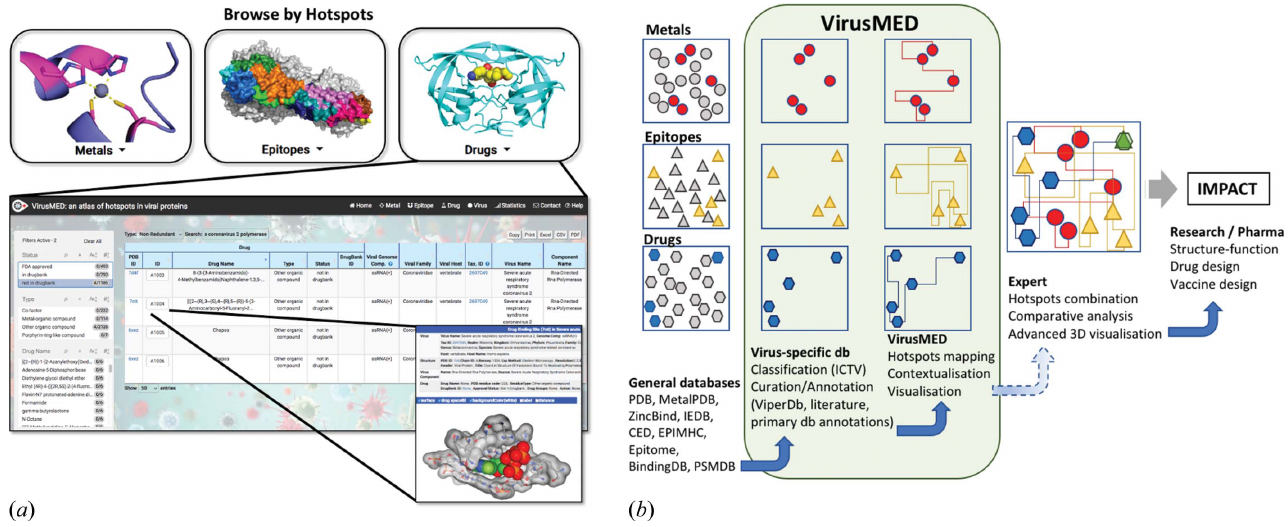
Figure 1 ( a ) virusMED is an atlas of hotspots present in viral proteins that correspond to metal binding sites, epitopes and drugs/small molecules. It is searchable by virus (not shown) and type of hotspot (top panel). Results are presented in a tabular form that can be filtered (middle panel) and mapped onto the 3D structure, providing context and a detailed view of the hotspot. ( b ) Schematic loosely based on a DIKW hierarchy. virusMED provides a navigation tool tailored to molecular virology that consolidates curated data available in various databases. This atlas is likely to facilitate research for viral families with a high volume of data, where expert analysis is time-consuming (coronaviruses, HIV, influenza viruses etc. ). The dotted lines indicate possible future developments that will further integrate the individual atlases and facilitate comparative analysis ( e.g. overlapping drug and epitope hotspots shown in